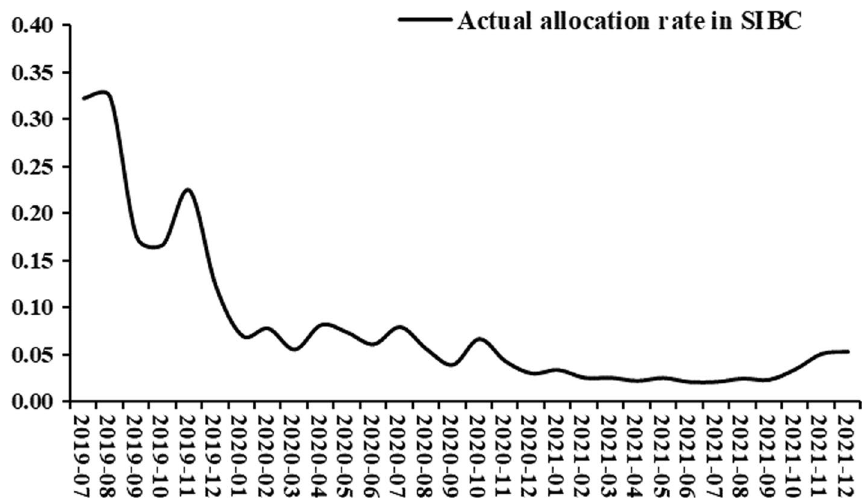
Fig. 17 monthly average of the actual allocation rate in SIBC’s inquiry